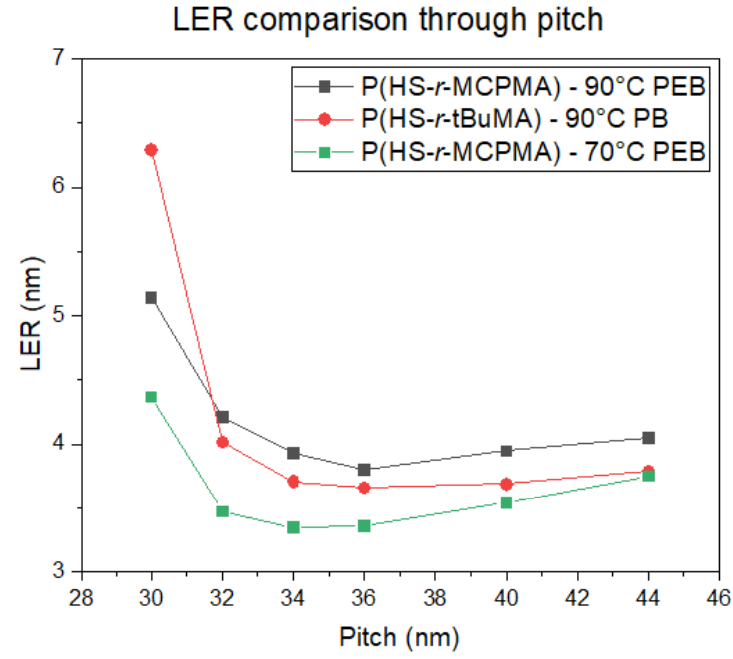
Figure 14. Unbiased line-edge roughness (LER) comparison between P(HS- r -tBuMA) and P(HS- r -MCPMA) resists.